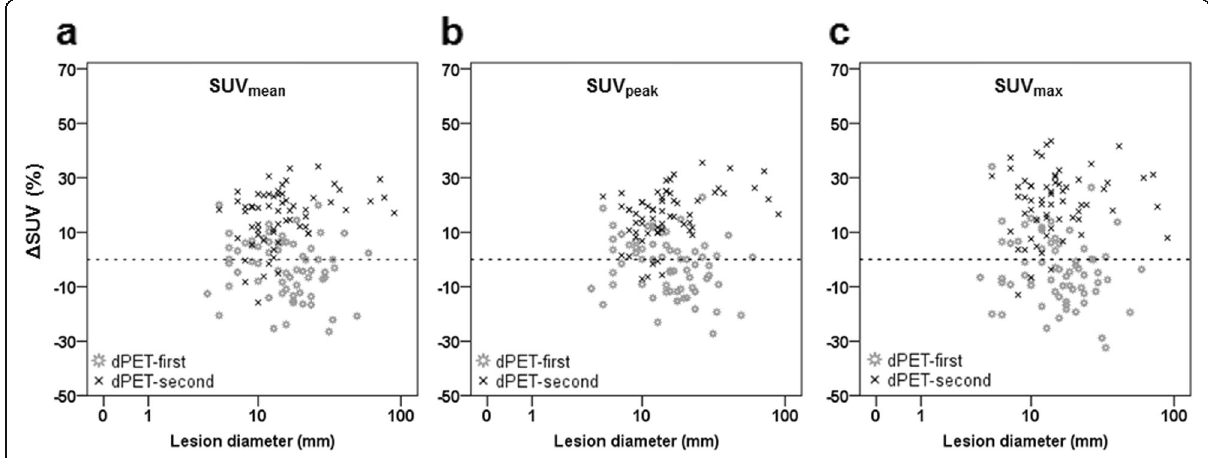
Fig. 4 Scatterplot comparing the relative change in SUV mean ( a ), SUV peak ( b ) and SUV max ( c ) with lesion diameter. The x -axis is shown on a log scale. There were no significant correlations between Δ SUV and lesion diameter with R = 0.09 for Δ SUV mean and Δ SUV peak ( p = 0.32), and R = 0.01 for Δ SUV max ( p = 0.96)